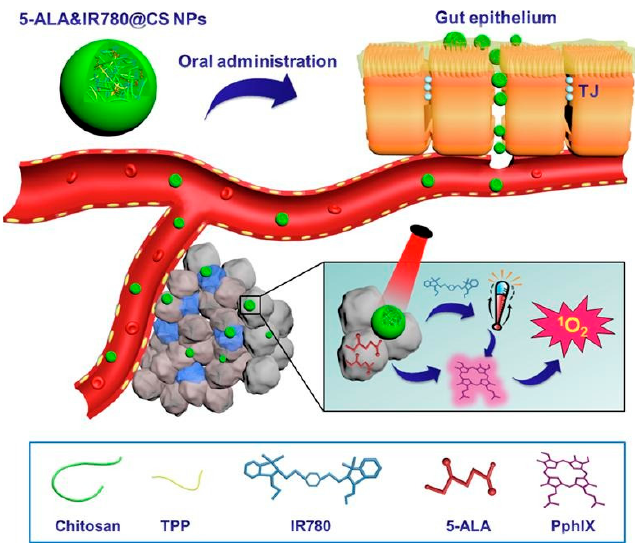
Figure 7. Schematic diagram of chitosan-nanoparticle-based 5-ALA and IR780 delivery for oral PTT and PDT in cancer treatment. Reproduced with permission from [113], 2020, Elsevier.